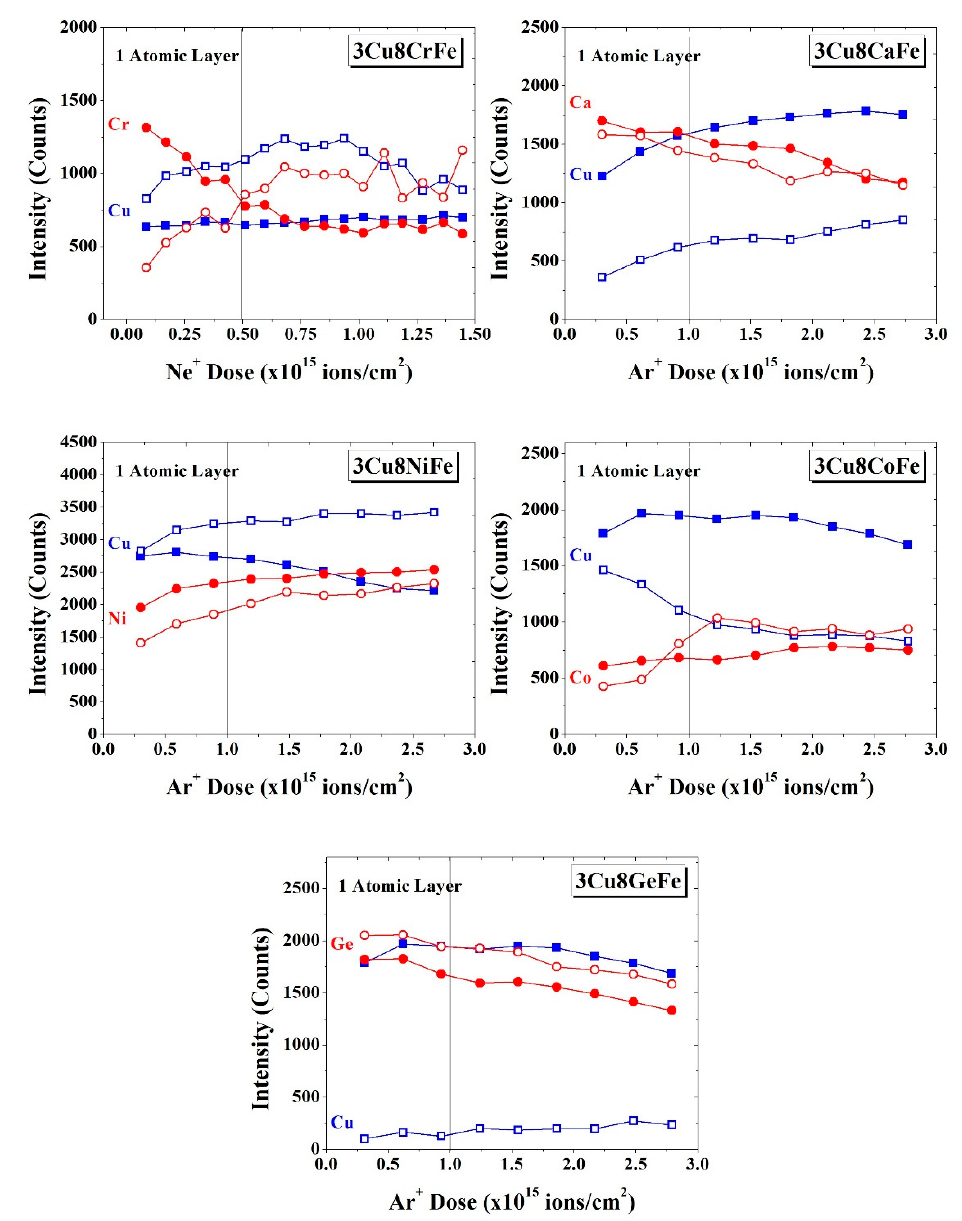
Figure 2. The HS-LEIS elemental intensity of Cu and M (M = Ca, Ni, Co and Ge) of calcined (solid symbols) and r-WGS reaction activated (empty symbols) for the 3Cu8MFe catalysts as a function of Ar + ion dose. The vertical dashed line indicates Ar + / Ne + sputtering of one atomic layer. For reference, HS-LEIS elemental analysis of the 3Cu8CrFe catalyst is also included in the figure, adapted with permission from [7]. 3Cu8CaFe: For the initially calcined catalyst, the intensity of the Ca signal continuously decreases with depth, indicating that Ca is surface enriched. The corresponding intensity of the Cu signal, however, increases with depth, indicating that Cu is surface depleted and is more concentrated below the outermost surface layer in the bulk lattice. After activation of the catalyst under r-WGS reaction conditions, no noticeable change in the intensity of the Ca signal takes place since Ca remains surface enriched. The corresponding intensity of the Cu signal, however, decreases by ~50%, reflecting sintering of the Cu (> 4 nm metallic Cu NPs, see Figure S1). The increasing intensity of the Cu signal